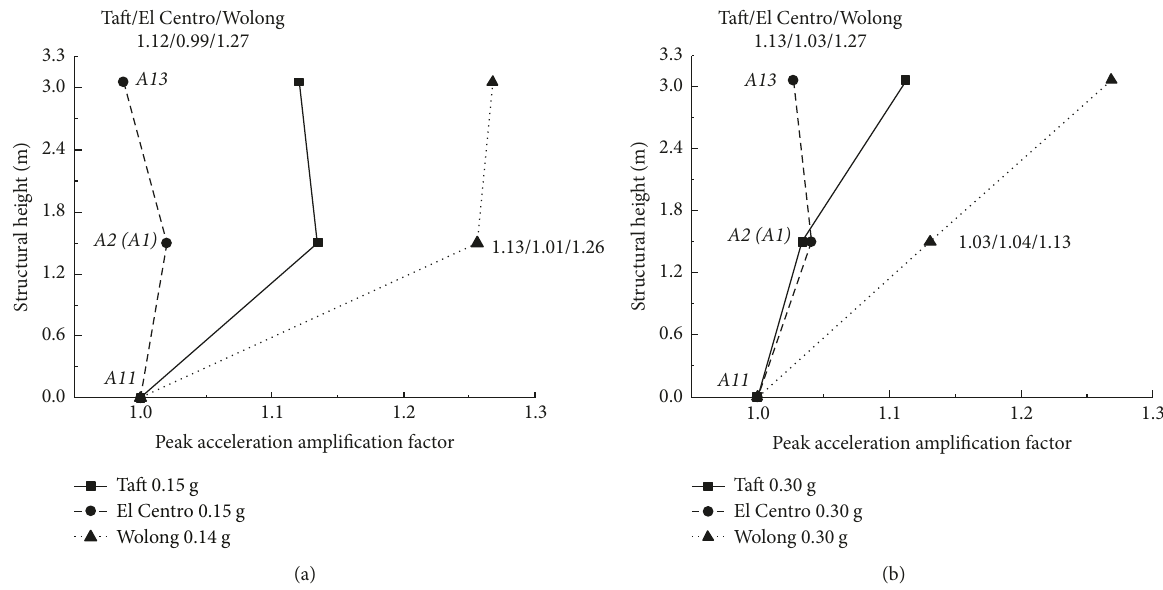
Figure 13: Comparison of out-of-plane peak acceleration amplification factors of the model for different input motions: (a) input motion with PGA = 0.15 g and (b) input motion with PGA = 0.3